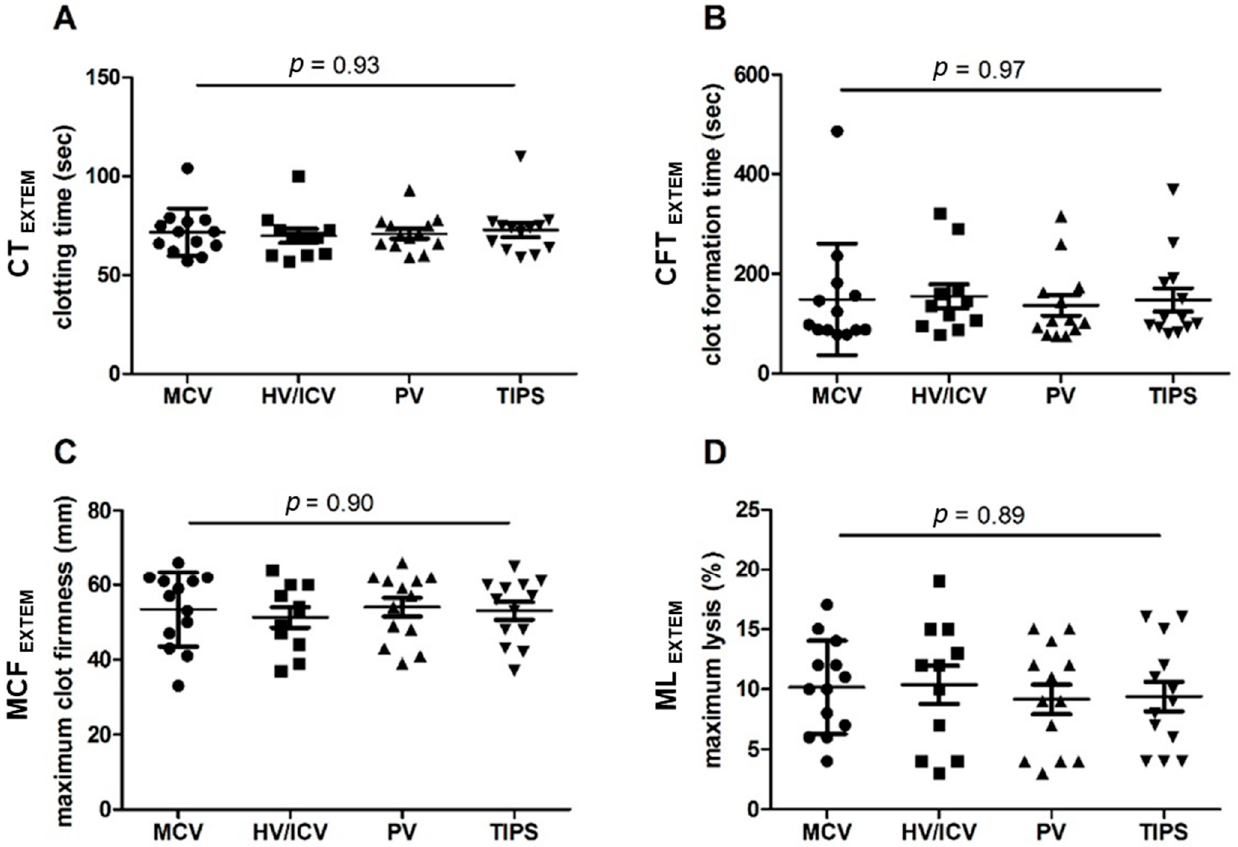
Figure 1. EXTEM/CT ( A ), EXTEM/CFT ( B ), EXTEM/MCF ( C ), and EXTEM/ML ( D ) measurements during TIPS implantation in patients with liver cirrhosis ( n = 13) in peripheral (MCV) vs. pre-hepatic (PV, TIPS) vs. post-hepatic (HV/ICV) blood samples. Results are presented as mean ± standard de- viation. Clotting time (CT); clot formation time (CFT); maximum clot firmness (MCF); maximum lysis (ML): reduction of the clot firmness (%) after MCF (in relation to MCF). Seconds (sec); millime- ters (mm). Median cubital vein (MCV); confluence of three hepatic veins to the inferior cava vein (HV/ICV); portal vein (PV); transjugular intrahepatic portosystemic shunt (TIPS). Table 2. Rotational Thromboelastometry (ROTEM ® ) measurements shown as median (min; max).